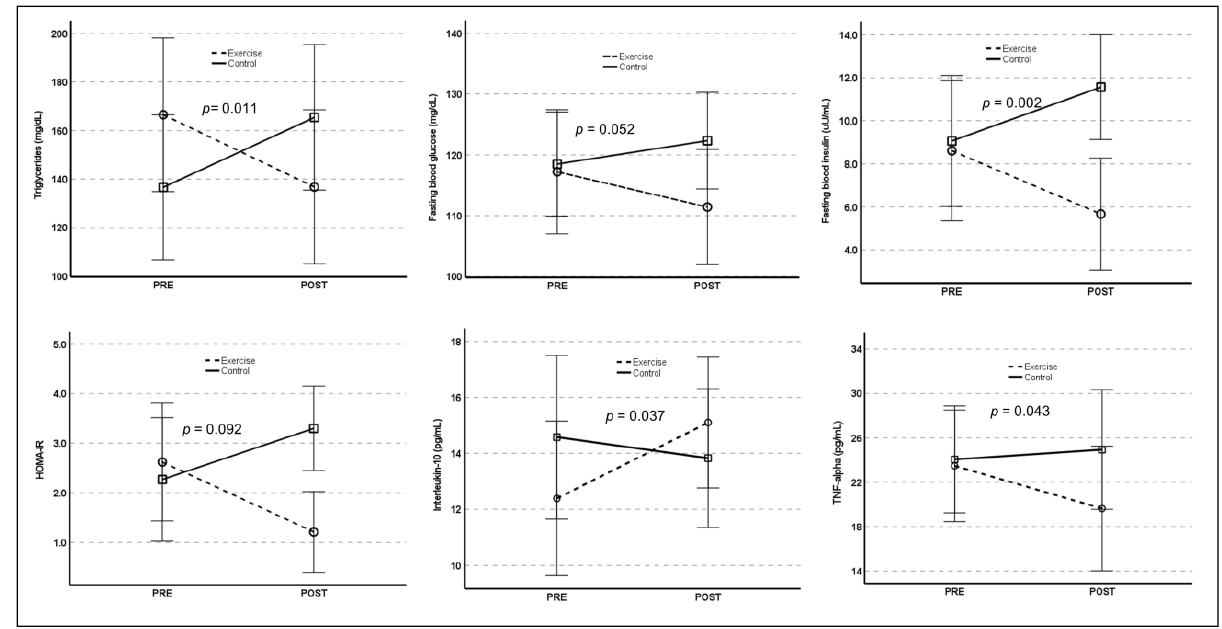
Figure 4. Illustration of time-by-group interactions for metabolic risk factors and serum cytokines.